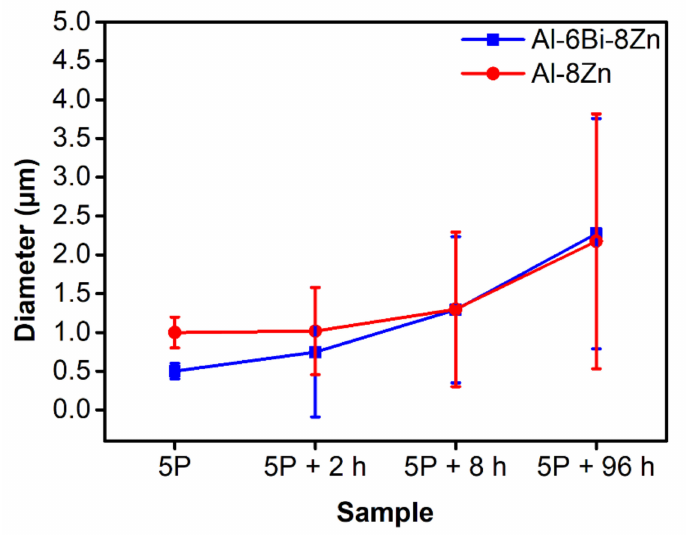
Figure 5. The evolution of average grain size for the as-deformed and annealed (at 200 ◦ C) Al-8Zn and Al-6Bi-8Zn